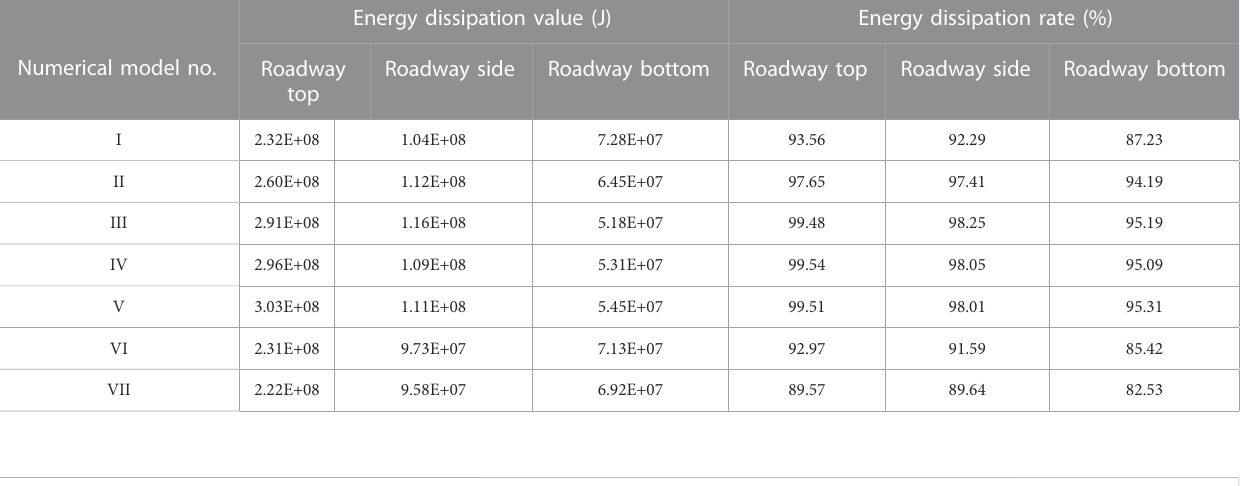
Numerical model no.